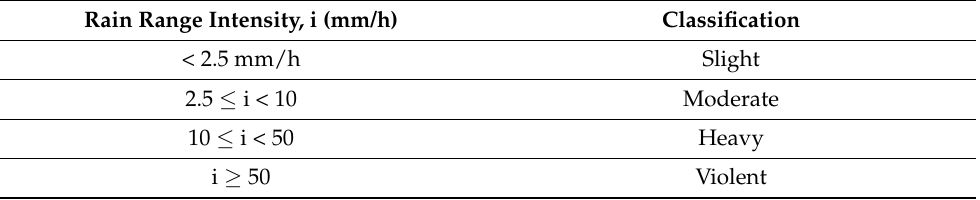
Table 1. Rain intensity classifications according to the World Meteorological Organization,